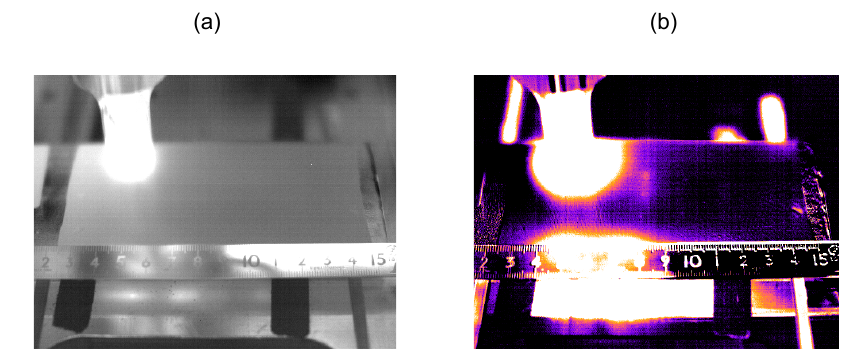
Figure 19. Results of sonic-IR testing for the stainless steel plate (reproduced from [49] with permission). ( a ) Raw infrared image; ( b ) self-reference lock-in